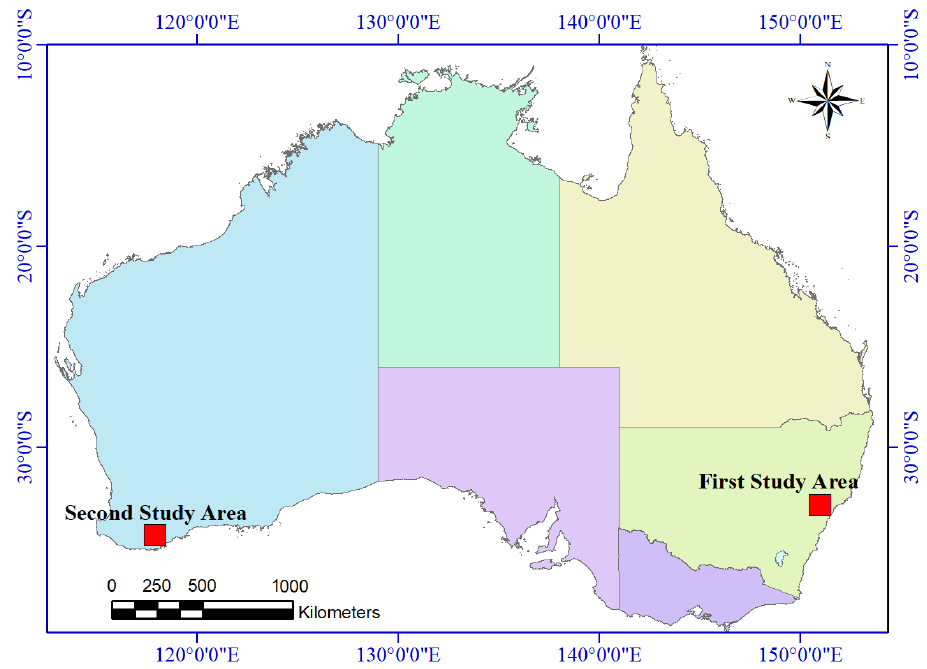
Figure 3. The locations of the two study areas for burned area mapping.